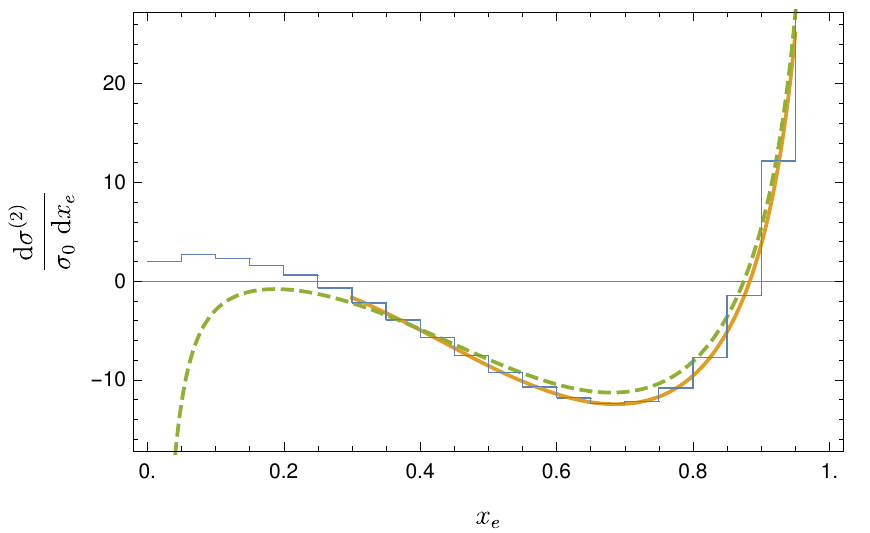
Figure 4 . The NNLO corrections to the electron energy spectrum, omitting a factor ( (cid:11)=(cid:25) ) 2 . The logarithmic contributions of [39, 40] (green dashed) agree reasonably well with our massive result (blue histogram) for large x e . Adding the constant terms of [41] (orange) we obtain good